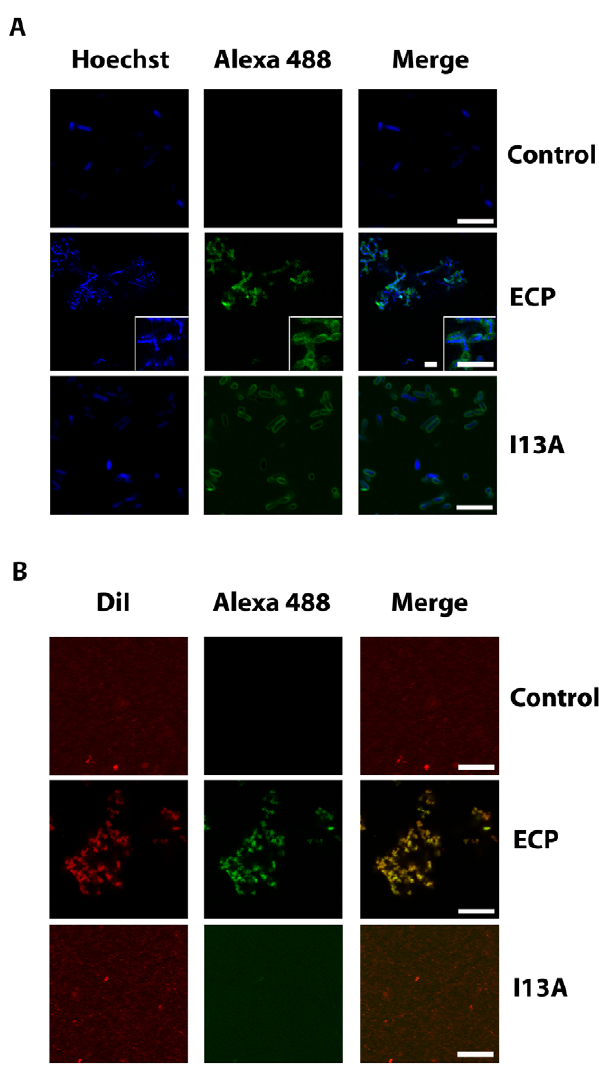
Figure 3. ECP and I13A mutant bind to the surface of bacteria and membranes. (A) E. coli bacteria cells stained with Hoechst (blue signal) were incubated with 5 m M of either wtECP or I13A mutant (both labeled with Alexa Fluor 488; green signal) for 4 h and visualized by confocal microscopy. In all experiments cell cultures were grown at exponential phase (OD 600 =0.2) and incubated with proteins in 10 mM sodium phosphate buffer, 100 mM NaCl, pH 7.4. (B) 500 m l of 200 m M LUV liposomes stained with DiI (red signal) were incubated with 5 m M of either wtECP or I13A mutant (both labeled with Alexa Fluor 488; green signal) for 4 h and visualized using a Leica SP2 confocal microscope. Scale bars are 5 m m length in all images and insight captions. Images depicted are representative from two independent experiments.